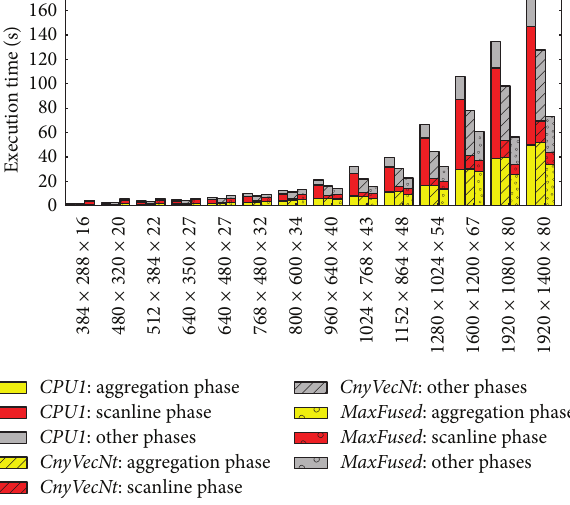
Figure 15: Low-disparity image series. Execution times with dif- ferent configurations, stacked bars divided into aggregation phase (yellow),scanlinephase(red),andallremainingpartsonhost(grey).